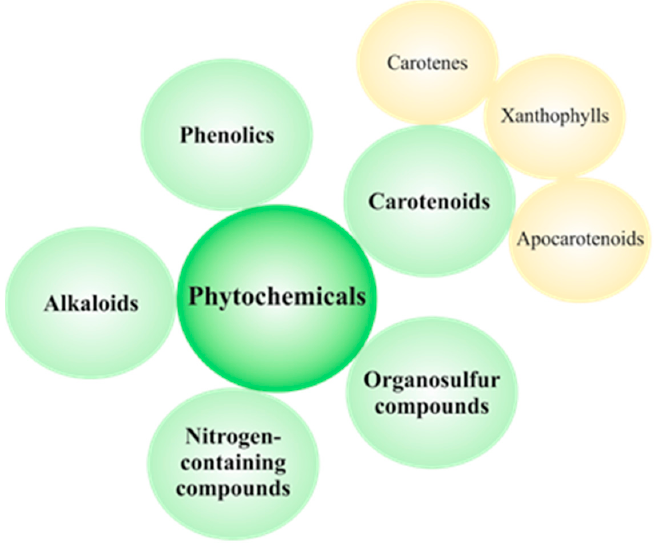
Figure 3. Classification of dietary phytochemicals . Phytochemicals are classified into five groups